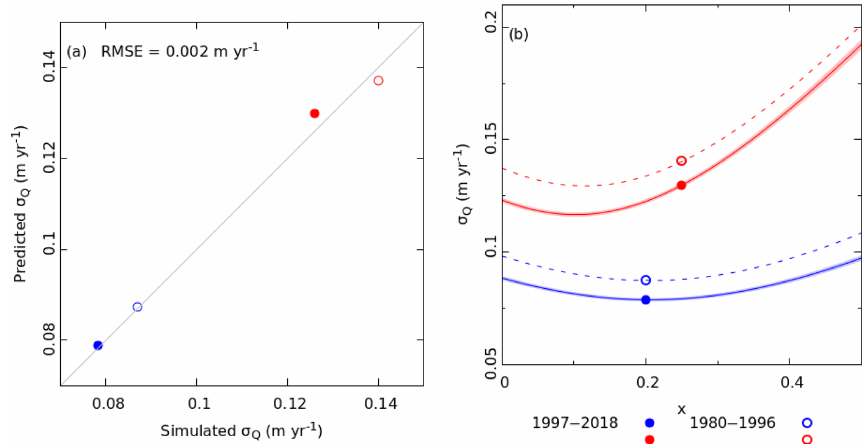
Figure 8. (a) Predicted σ Q using Eq. (14) are compared with the corresponding simulated values for both catchments. The solid and open circles denote data for the periods 1997–2018 and 1980–1996, respectively. Data for the Chandra and upper Dudhkoshi catchments are shown with red and blue symbols, respectively. (b) The solid (dashed) lines show σ Q (x) obtained using σ P and σ T values from 1997–2018